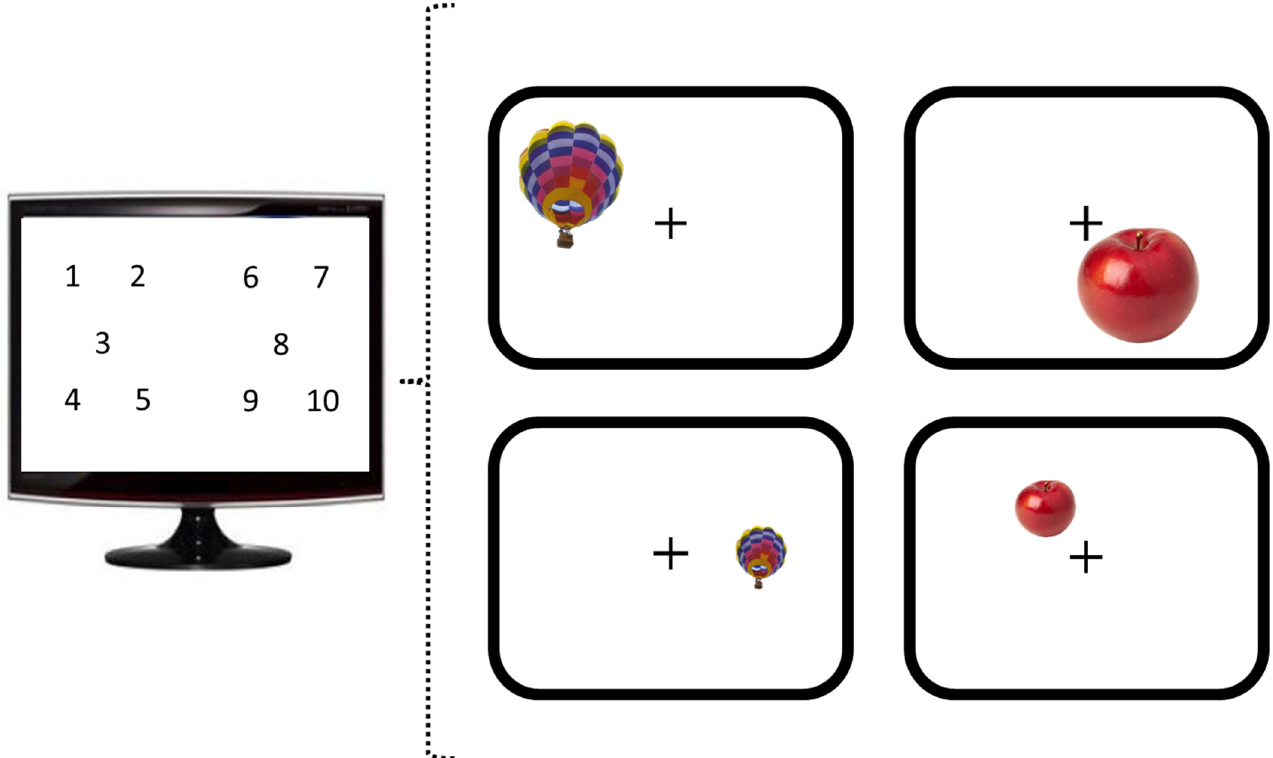
Figure 2. Positions of stimulus appearance and illustration of the four experimental conditions. Stimuli appeared on ten different positions on the screen. Images of single objects were shown at large ( top row ) and small ( bottom row ) display sizes.